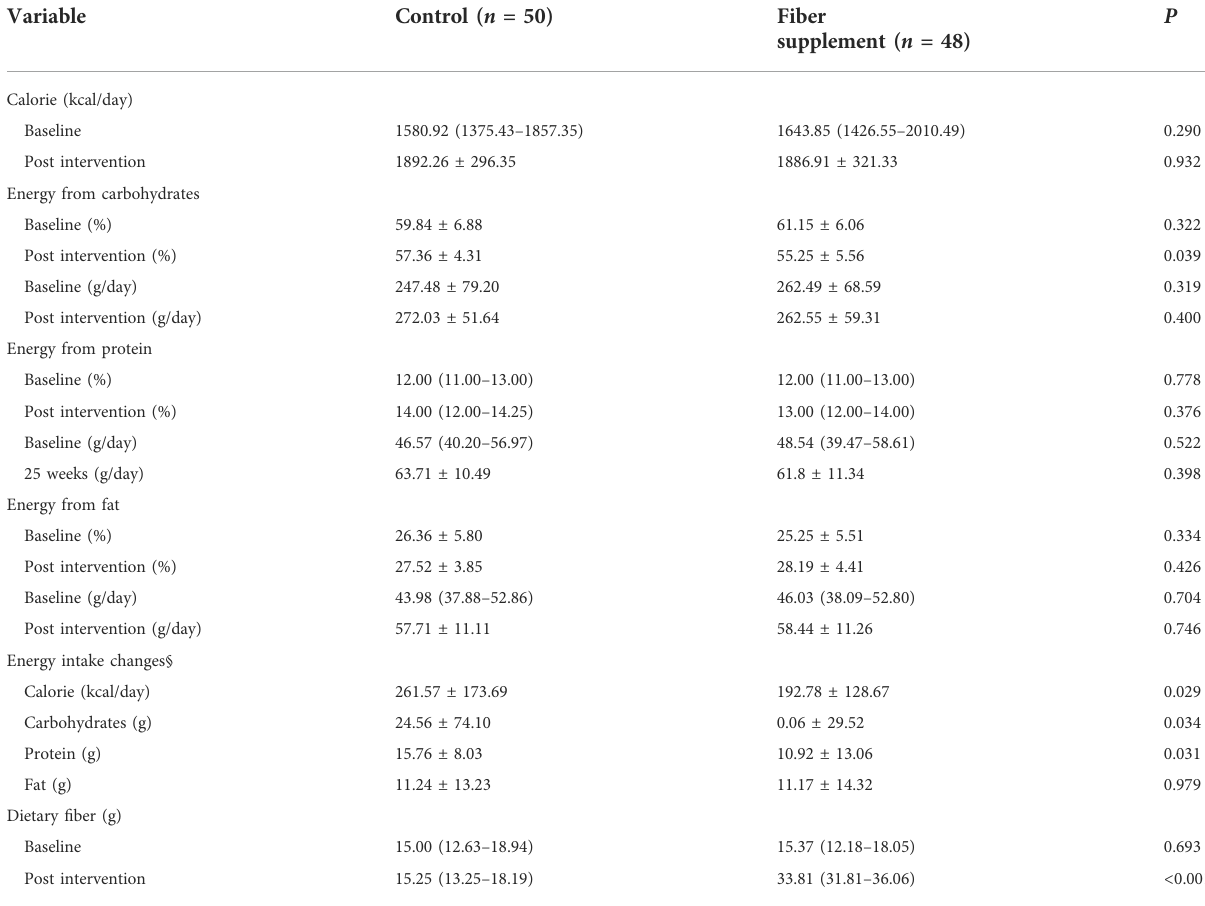
TABLE 4 Comparison of dietary intake within and between the group at the base and post intervention.